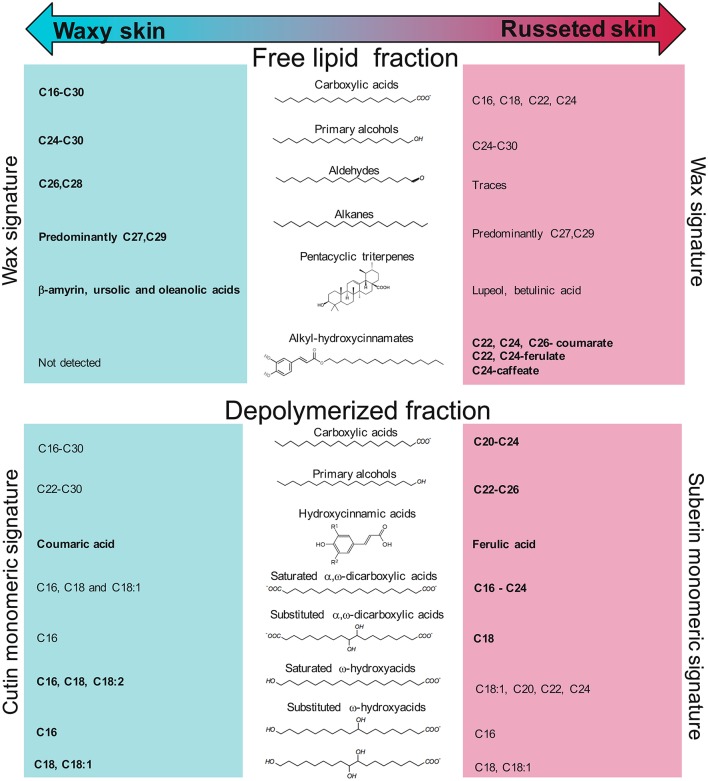
Overview of the metabolites found in the free lipid and depolymerized fractions of the “Cox orange Pippin” waxy and russeted skins. Compounds highlighted in bold indicate the global higher concentrations of their respective family in the tissue.